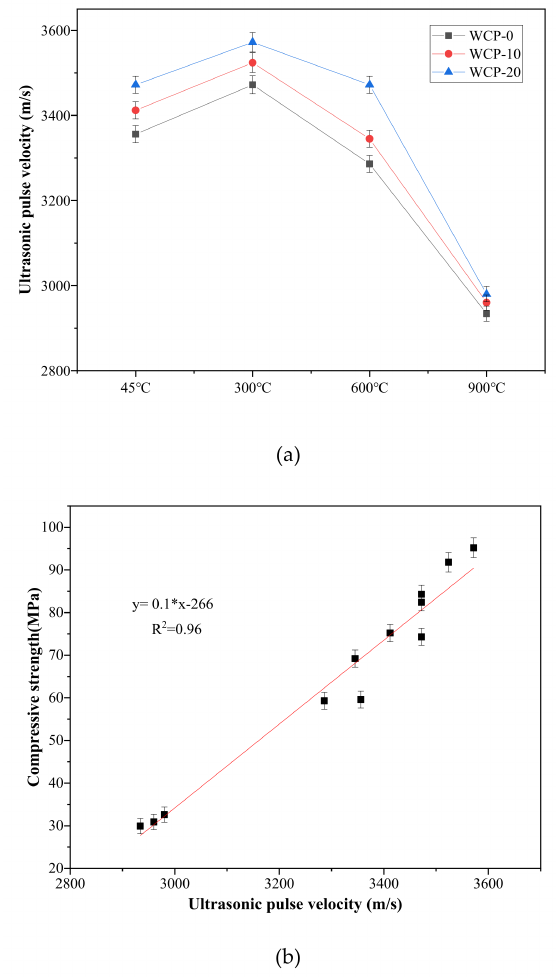
Figure 6. ( a ) UPV of mixed pastes at 45, 300, 600 and 900 ◦ C; ( b ) The relationship between compressive strength and UPV.